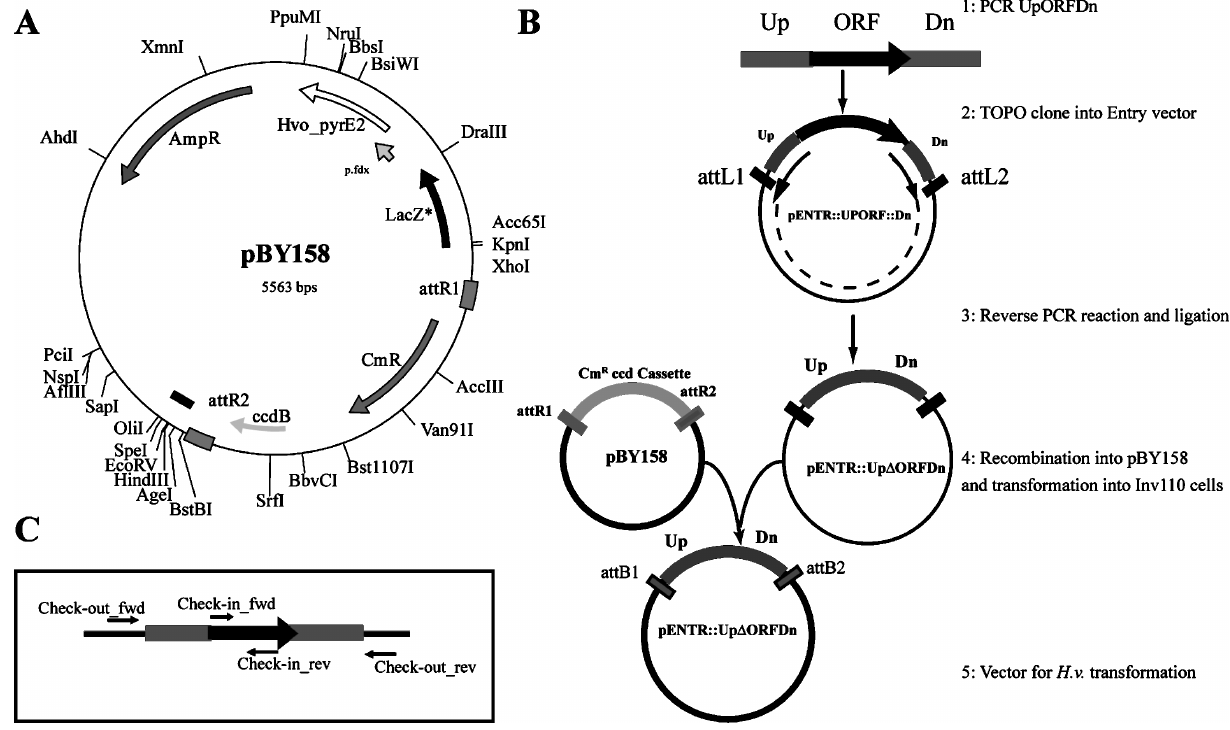
Figure 1. Haloferax volcanii deletion cassette construction using pBY158, an H. volcanii gateway suicide vector. A. Map of pBY158. B.